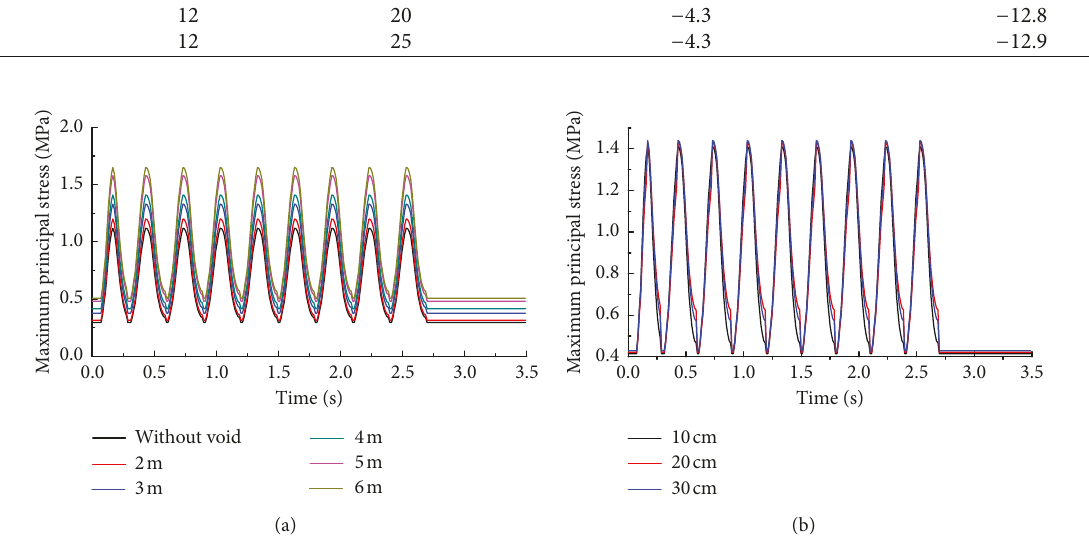
Figure 11: Time-history curves for maximum principal stress at the inverted arch. (a) Maximum principal stress of the inverted arch under different void widths (with a void thickness of 10cm). (b) Maximum principal stress of the inverted arch under different void thicknesses (with a void width of